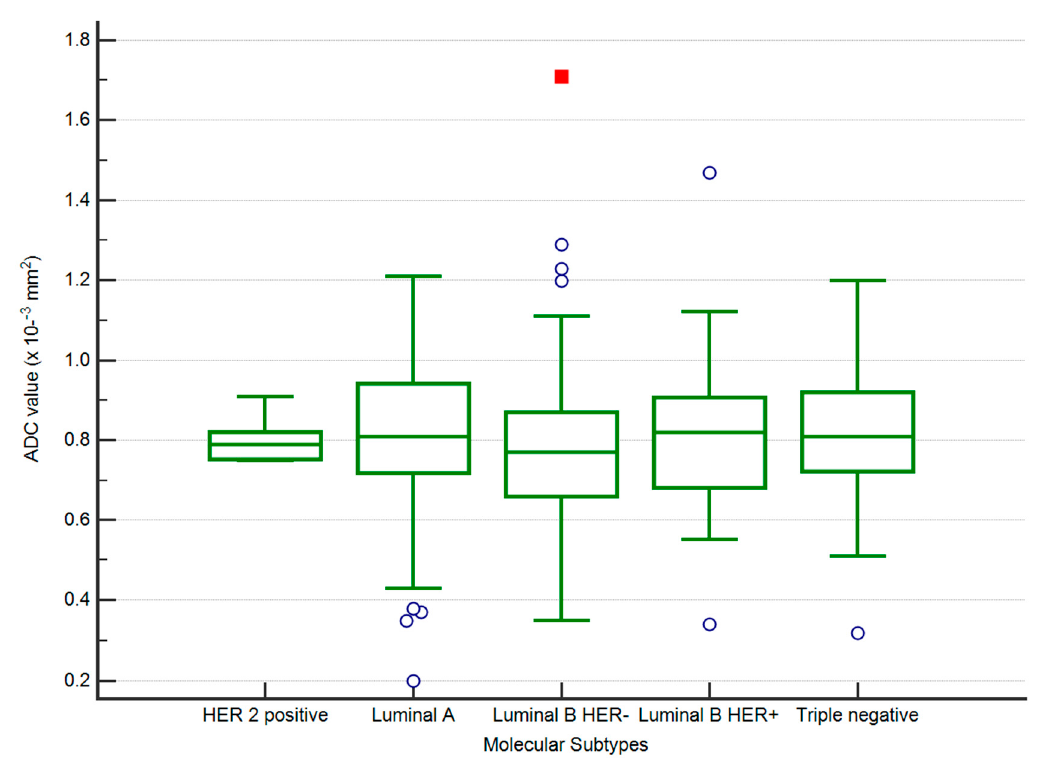
Figure 6. The distribution of ADC values in luminal B HER2 negative and other subtypes of BC.